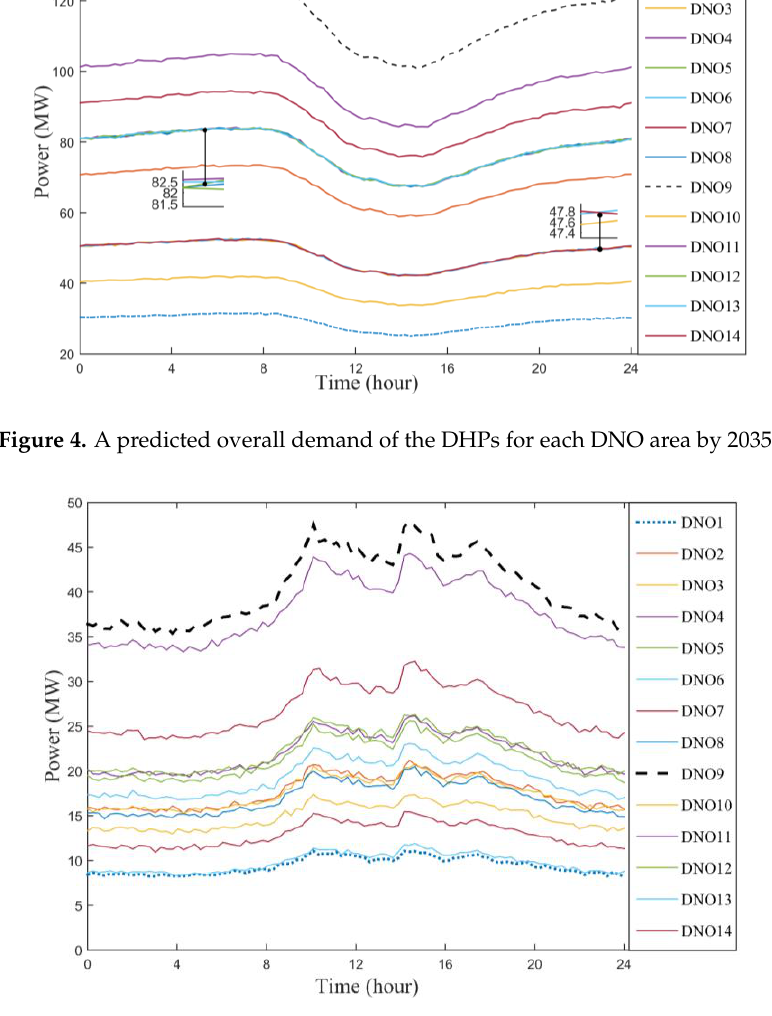
Figure 5. Available demand reduction using the DHPs for each DNO area by 2035, considering the inside temperatures of buildings between 18–21°C.